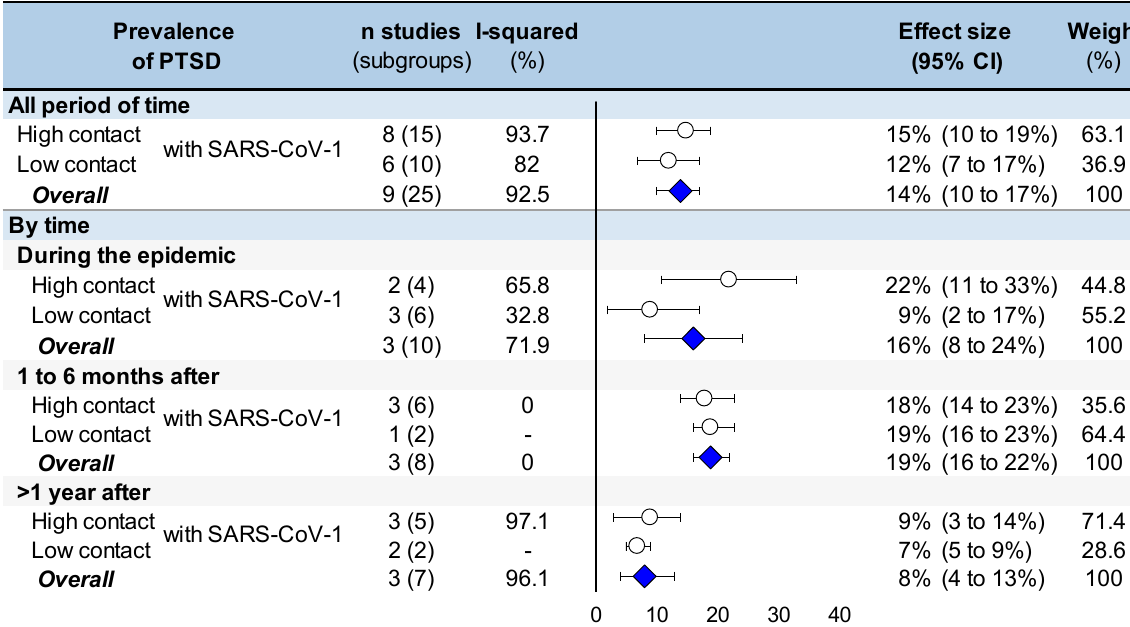
Figure 4. Summary of meta-analysis on prevalence of post-traumatic stress disorder following the SARS-CoV-1 epidemic of 2003, by contact with SARS-CoV-1 (high or low contact) and by time (follow-up). Each summary of meta-analysis is represented in the forest-plot by a white circle (dot) on a horizontal line. The dots represent the pooled-effect estimate (i.e., prevalence in this case), and the length of each line around the dots represent their 95% confidence interval (95CI). An overall summary of the results of meta-analyses is represented by a blue lozenge below.